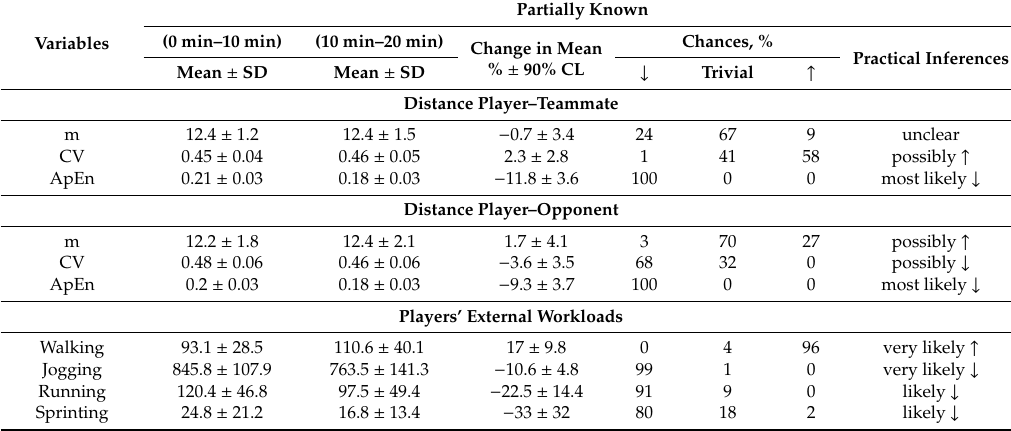
Table 2. Descriptive statistics when comparing (0 min–10 min) vs. (10 min–20 min) for the Partially known condition game